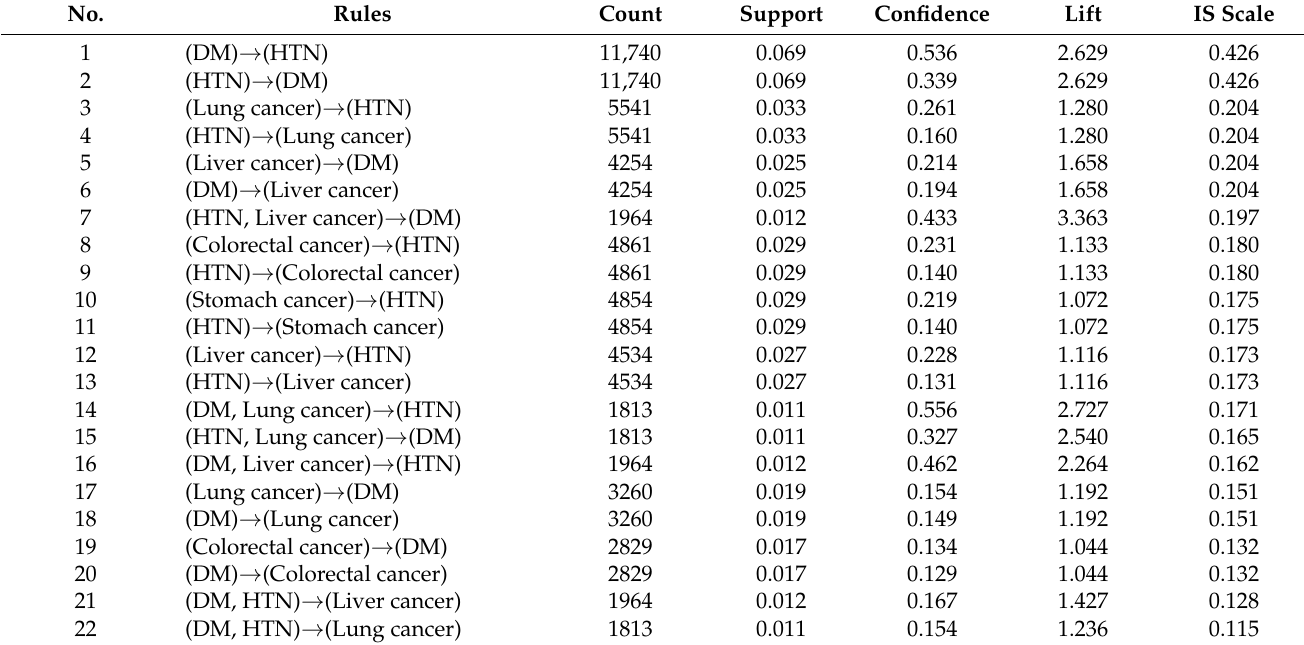
Table 3. Association rule mining between cancer disease, diabetes mellitus, and